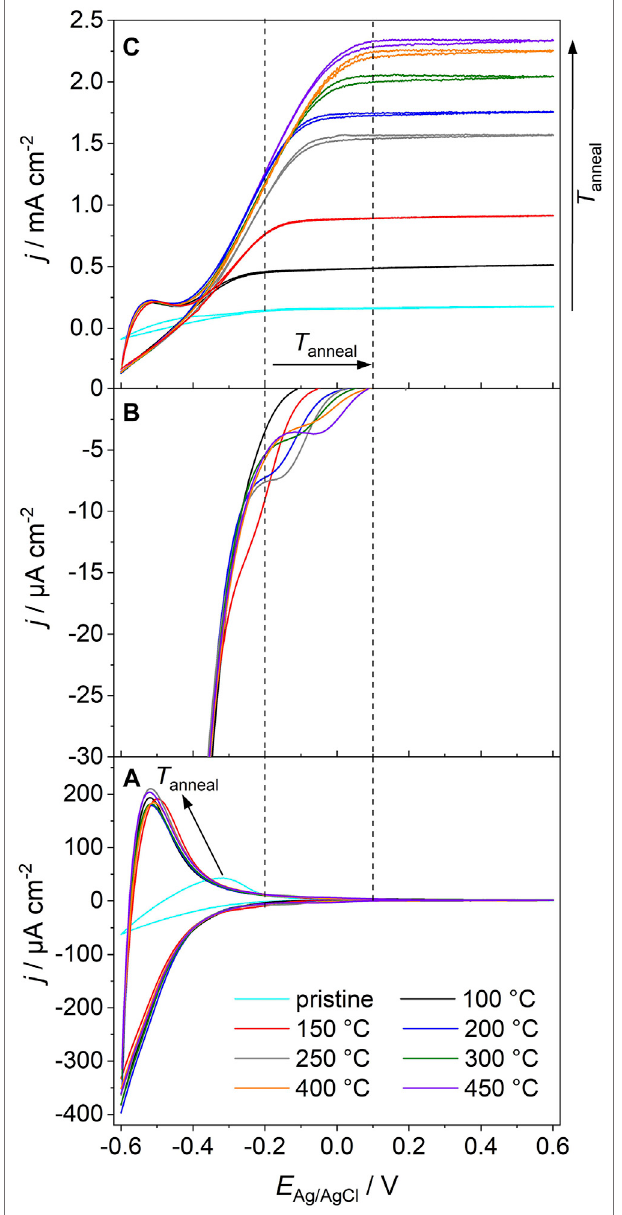
FIGURE 1 | (A) Cyclicvoltammograms(measuredintheabsenceofUVlight) of a pristine anatase TiO 2 nanoparticle electrode and of an electrode, which was sequentially annealed at 100 ° C ≤ T anneal ≤ 450 ° C. (B) Ampli fi cation of capacitive currents in the potential range − 0.35 V ≤ E ≤ 0.1 V [corresponding to the cathodic scansin (A) ] for theannealed electrodes. (C) Cyclicvoltammogramsofthe pristine and the annealed electrodes as recorded upon electrode exposure to polychromatic UV/Vis light ( P (cid:1) 500 mW cm − 2 ). Electrolyte: N 2 -purged 1 M MeOH/ 0.1 M